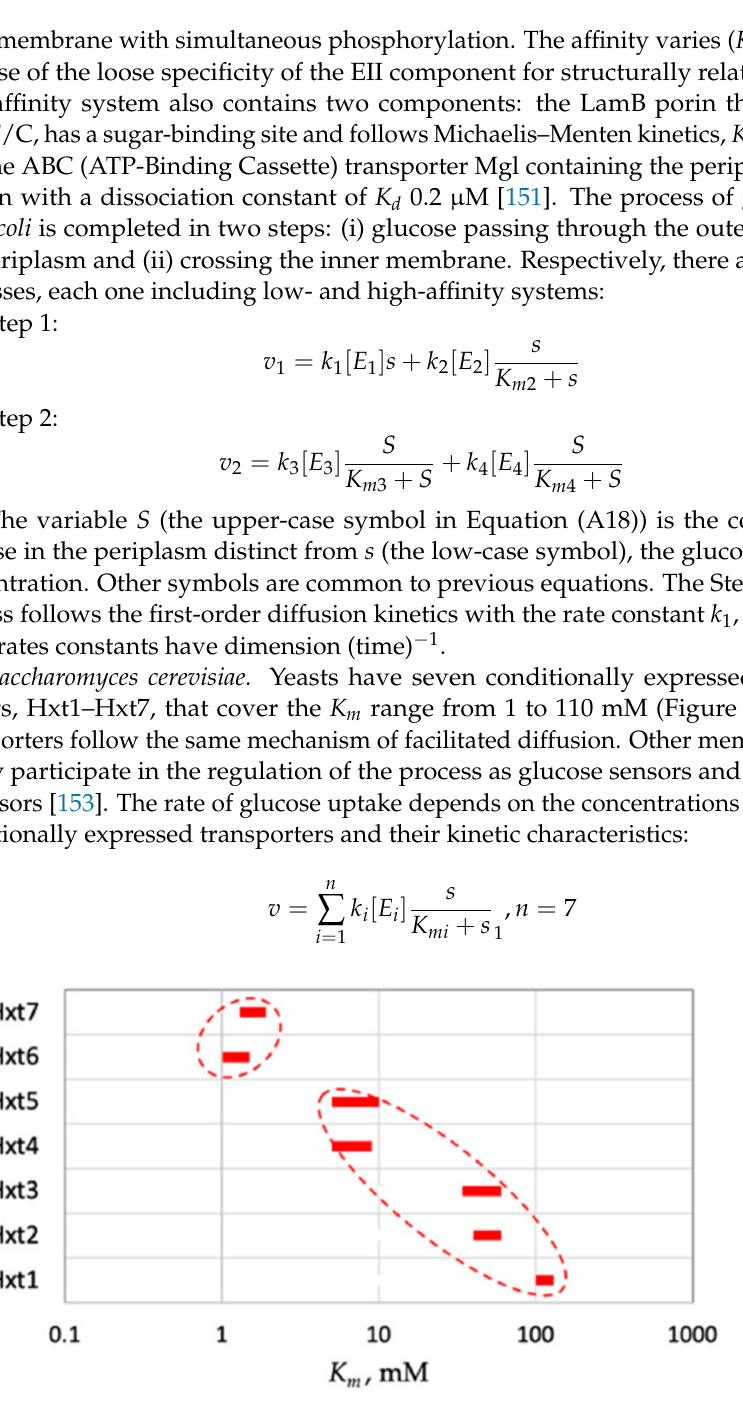
Figure A3. Conditionally expressed hexose transporters of S. cerevisiae, based on Reference [153]. Encircled clusters are assumed to be the high- ( left ) and low-affinity transporters ( right